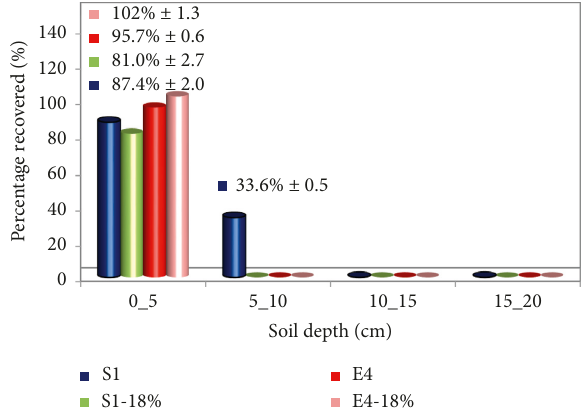
Figure 4: Distribution of penconazole in natural and amended soils.